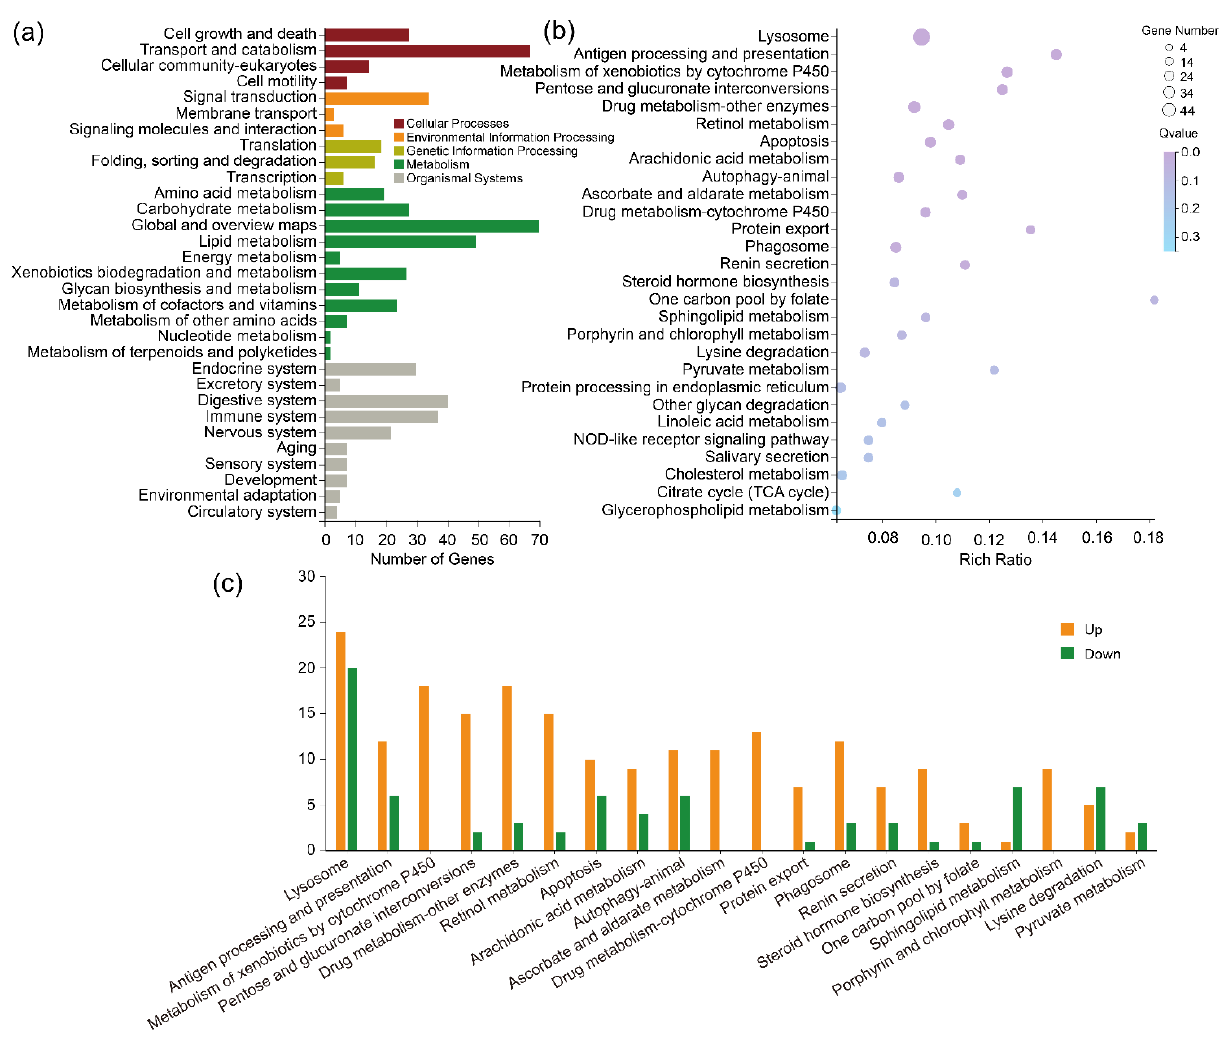
Figure 8. Kyoto Encyclopedia of Genes and Genomes (KEGG) analysis of differentially expressed genes from the bifenthrin ‐ resistant (R_bft) strain of T. urticae ; ( a ) classified KEGG pathways; ( b ) enriched KEGG pathways; ( c ) the number of differently expressed genes in the most enriched pathways.